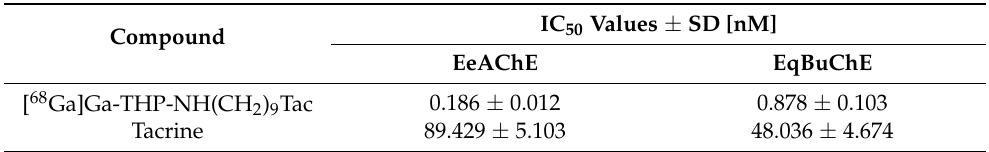
Table 4. Cholinesterase inhibitory activities of [ 68 Ga]Ga-THP-NH(CH 2 ) 9 Tac radiocompound and tacrine as a reference compound.